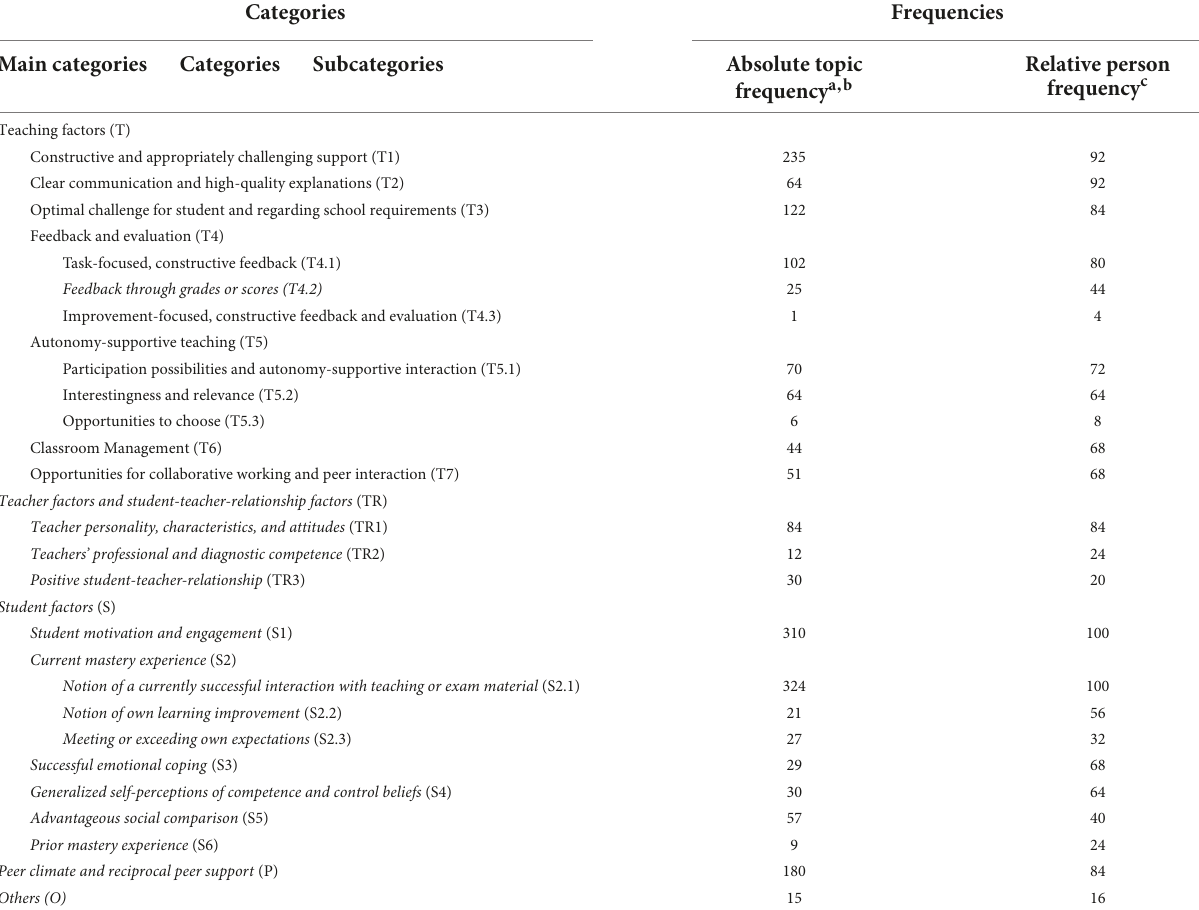
TABLE 1 Factors contributing to students’ competence satisfaction through students’